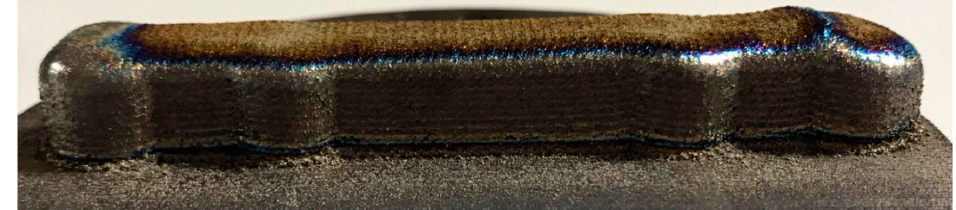
Figure 11. Incipient bulk bone plate shape obtained by Laser Melting Deposition (LMD) printing on a Ti substrate.